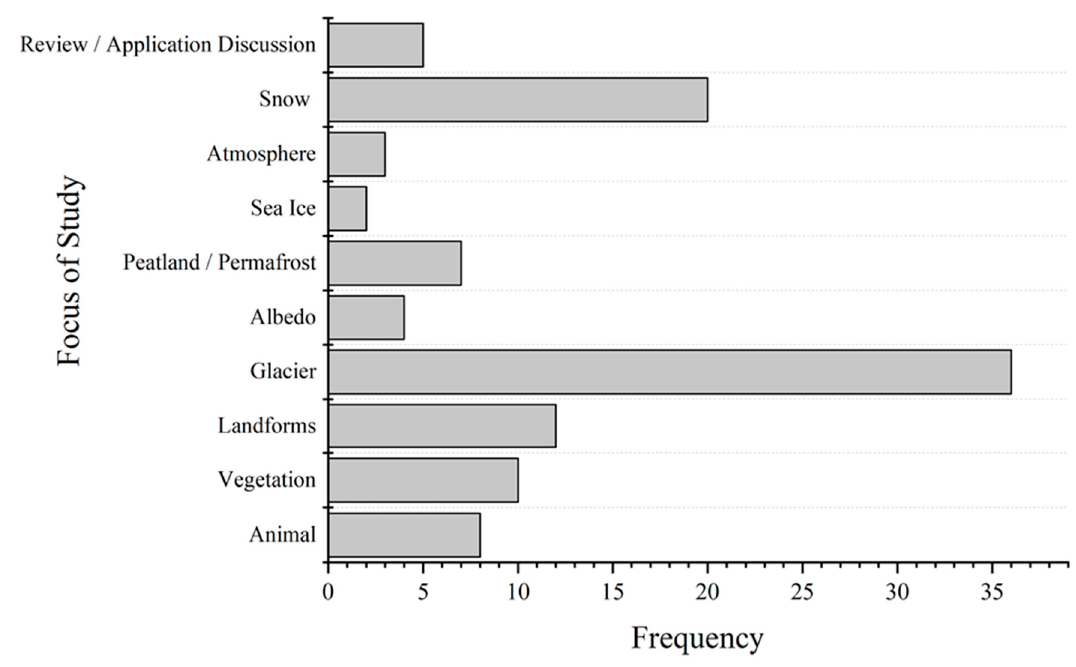
Figure 1. Distribution of main topics of recently published studies utilizing UAVs for cryosphere research. This plot consists of the studies that were published as complete research articles in peer-reviewed journals and conference proceedings, or as university degree theses made available online between 2014 and 2019.